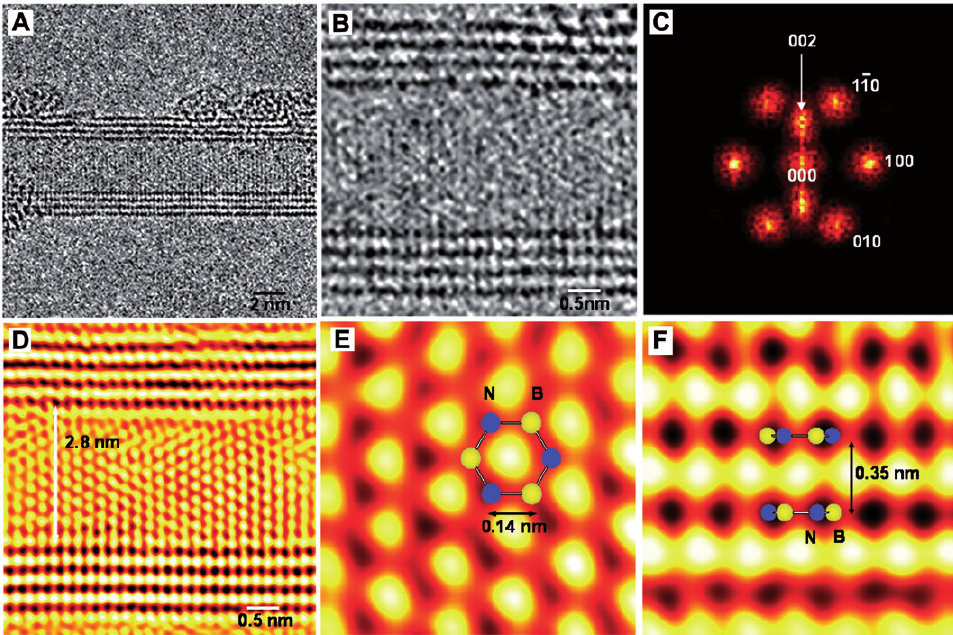
Figure 17 (A) HREM image of zigzag-type BN nanotube. (B) Enlarged HREM image of (A). (C) Filtered Fourier transform of (B).